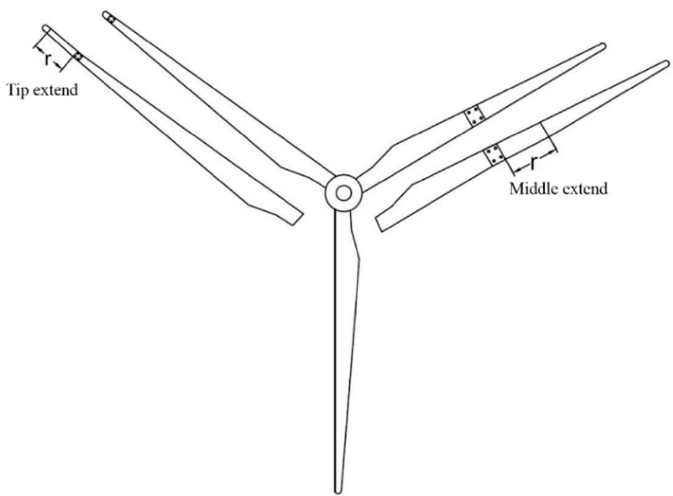
Figure 1. Schematic of the extensible blade concept (with an illustration of extension at the tip and middle of the blade).